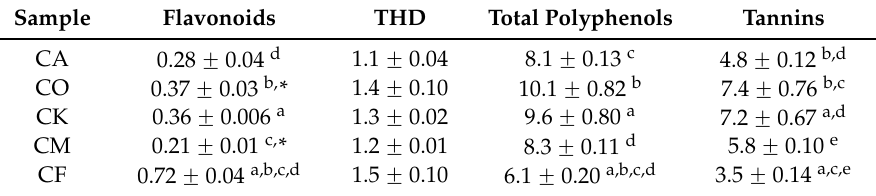
Table 2. Content (w%) of secondary metabolites in aqueous leaves extracts of five Cornus species.